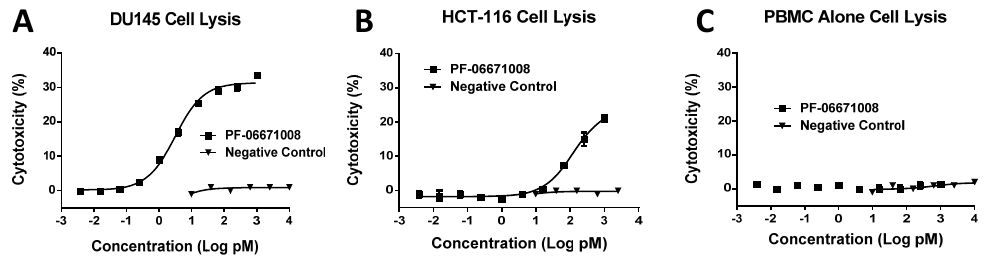
Figure 7. Dose ‐ response curves of PF ‐ 06671008 or control DART (4420 ‐ LP) ‐ mediated cytotoxicity Figure 7. Dose-response curves of PF-06671008 or control DART (4420-LP)-mediated cytotoxicity measured using the lactate dehydrogenase (LDH) assay with primary human peripheral blood